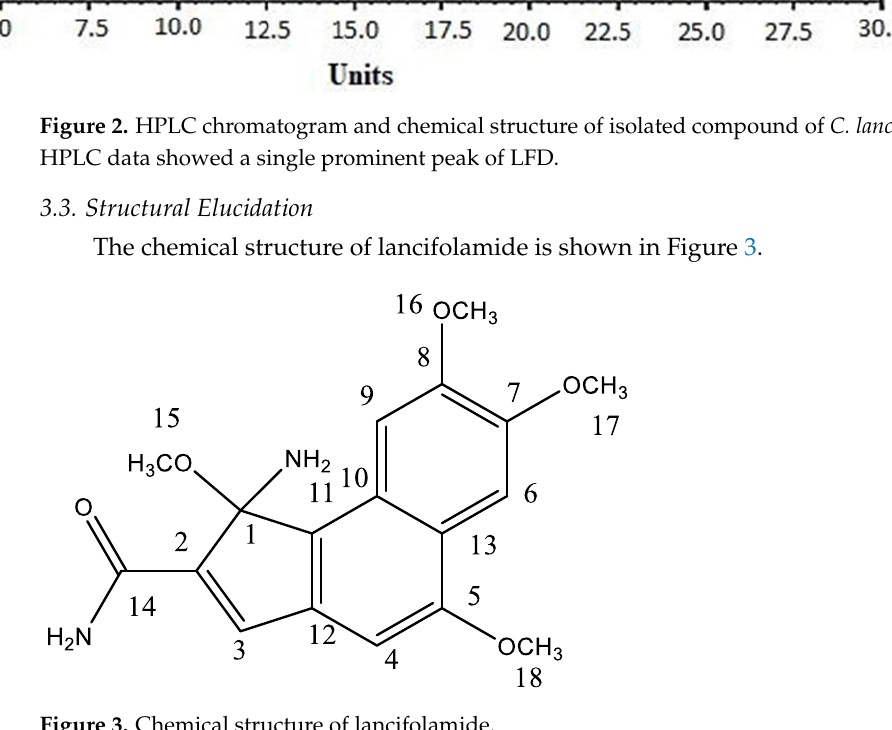
Figure 3. Chemical structure of lancifolamide.